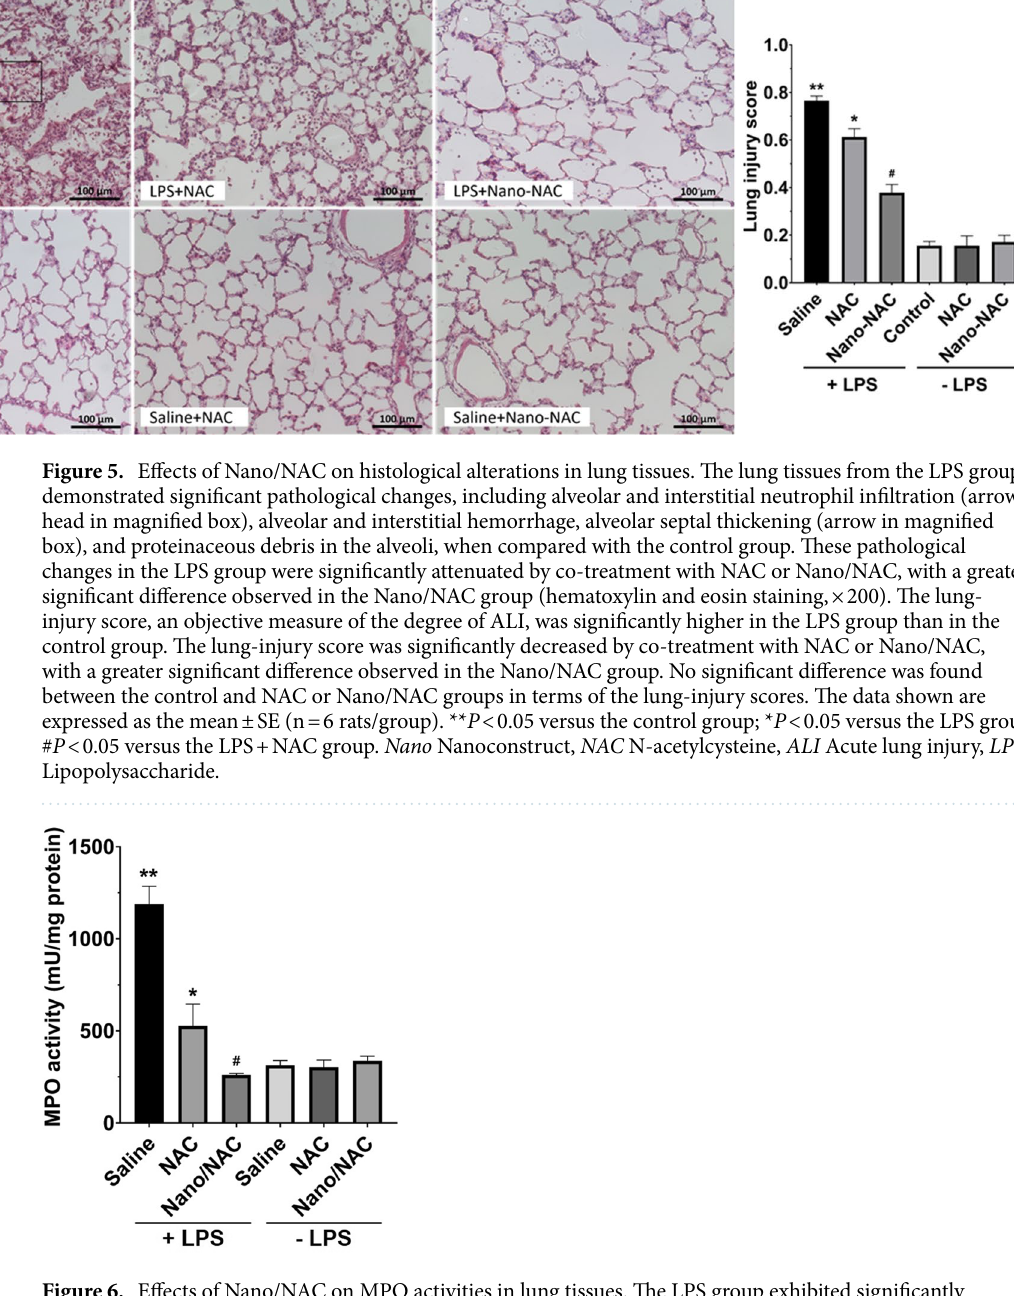
Figure 6. Effects of Nano/NAC on MPO activities in lung tissues. The LPS group exhibited significantly higher MPO activities than the control group. The LPS + NAC group showed significantly lower MPO activities than the LPS group. The LPS + Nano/NAC group showed significantly lower MPO activities than the LPS + NAC group. The data shown are expressed as the mean ± SE (n = 6 rats/group). ** P < 0.05 versus the control group; * P < 0.05 versus the LPS group; # P < 0.05 versus the LPS + NAC group. Nano Nanoconstruct, NAC N-acetylcysteine, MPO Myeloperoxidase, LPS